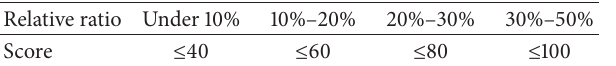
Table 8: Scoring method according to number of sight distance defect sections.